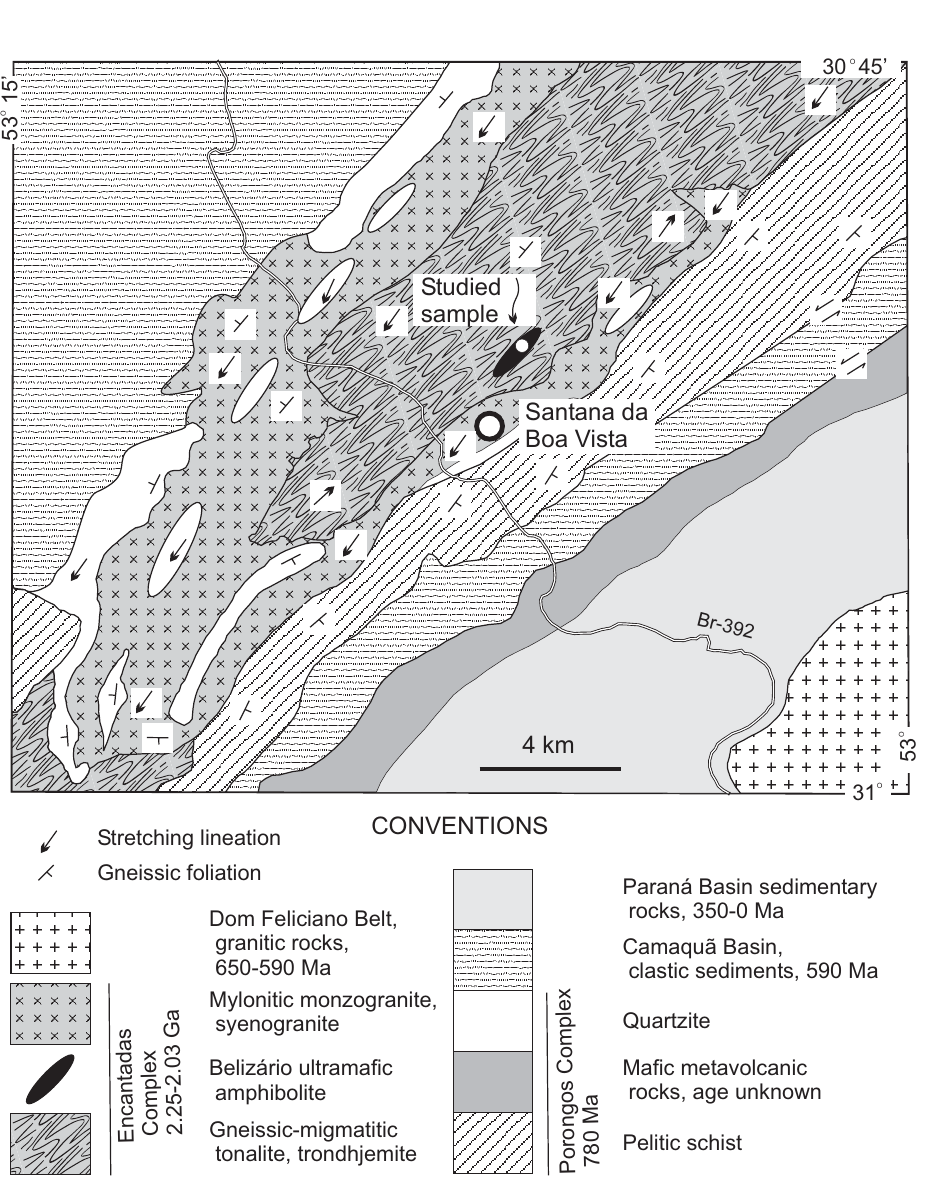
Fig. 2 – Geological map of the Santana da Boa Vista region (from Hartmann et al. 2000b). Location of studied ultramafic amphibolite sample